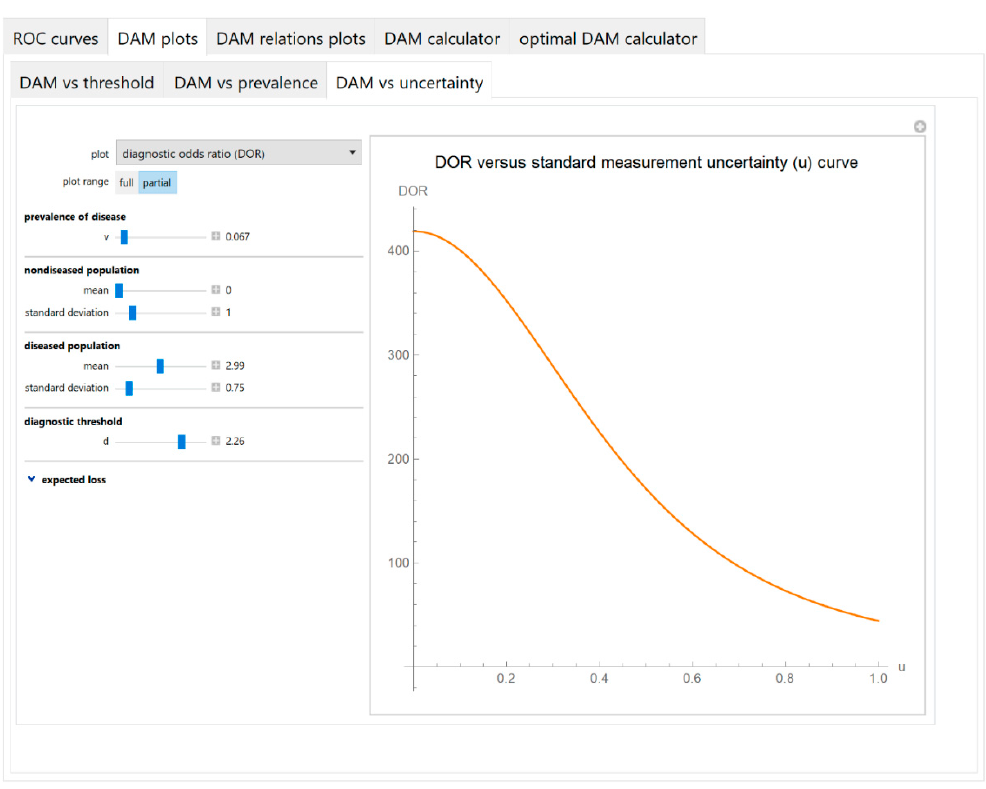
Figure 5. DAM plots module, DAM against prevalence submodule screenshot. Ratio of the negative predictive value ( NPV ) of the two screening or diagnostic tests measuring the same measurand with different uncertainties, against prevalence ( v ) of the disease curve plot, with the settings at the left.